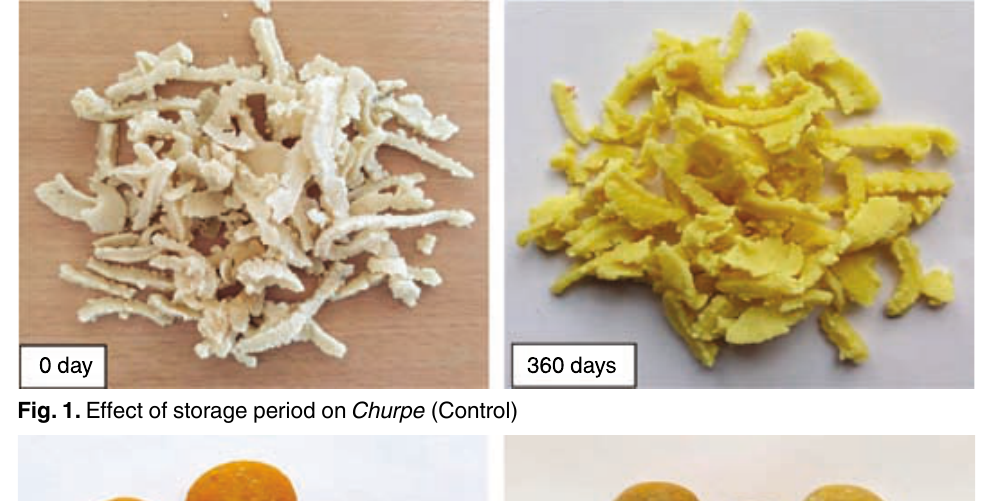
Fig. 1. Effect of storage period on Churpe (Control)